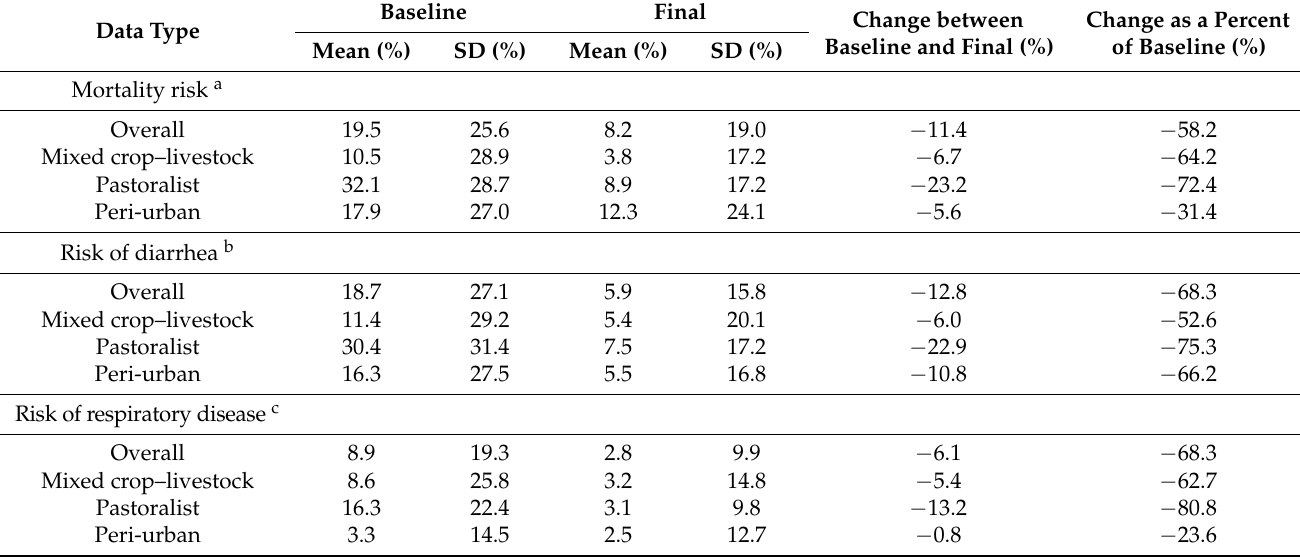
Table 13. Summary statistics for risk of mortality, diarrhea, and respiratory disease risk in calves.